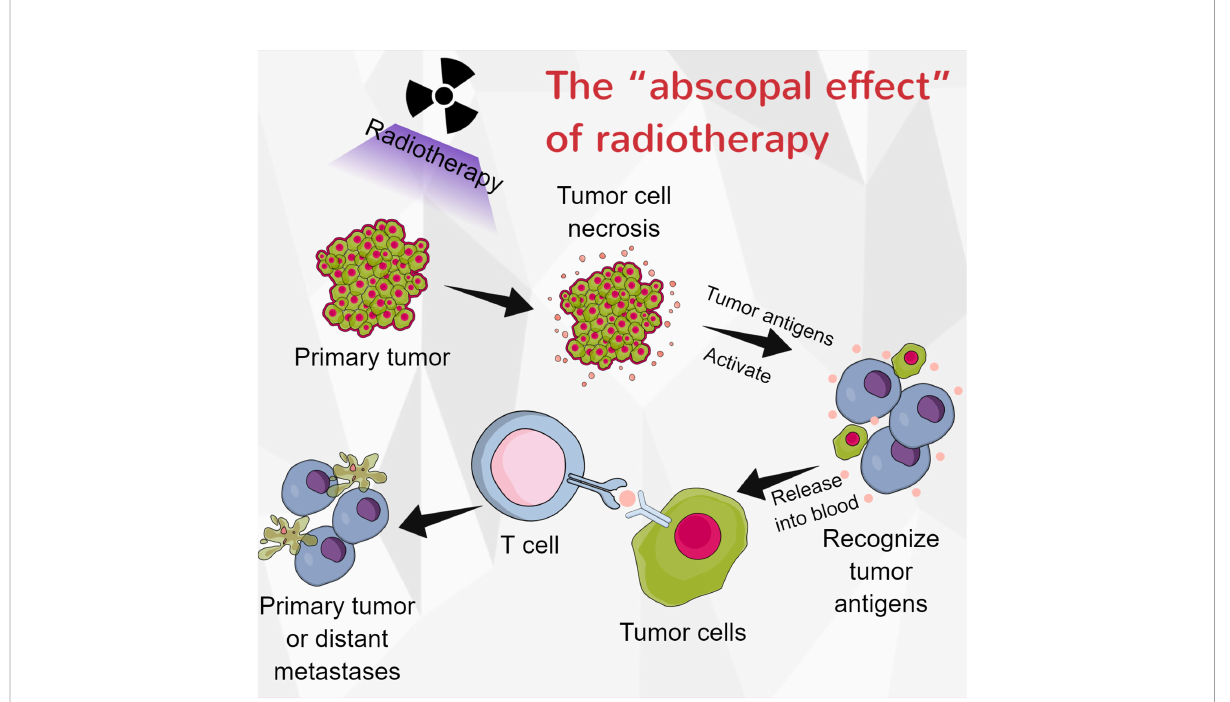
FIGURE 3 The “ abscopal effect ” of radiotherapy. When tumor-cell necrosis is induced by radiotherapy, the antigens with the cells are released into the blood, and they can be recognized by immune cells. These activated immune cells could then eliminate the primary tumor or distant